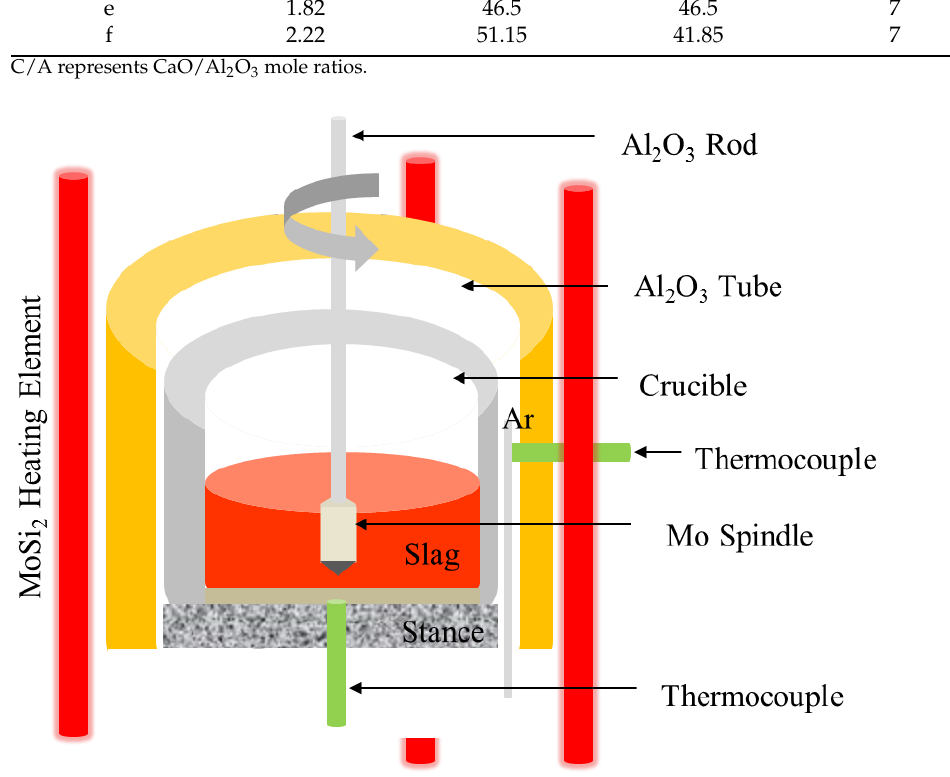
Figure 2. In the RDFs curve, the abscissa value corresponding to the first peak in the curve represents the average bond length of the particle pair. It can be seen from Figure 2a that the average bond length of Al-O, Ca-O, B-O, and O-O is 1.76, 2.33, 1.36, and 2.76 Å , re- spectively. L. Cormier et al. [23] proposed the Al-O and Ca-O bond length in calcium alu- minosilicate glasses is 1.76 and 2.35 Å by neutron diffraction. The B-O bond length in soda- boric oxide glass obtained by X-ray diffraction patterns is 1.37 Å [24]. The bond length values in this study are in good agreement with the experimental data, indicating that the MD simulations are reliable and accurate. Further analysis showed that the bond length of each particle pair in this study was not affected by the change in the CaO/Al 2 O 3 ratio and the addition of B 2 O 3 , as shown in Table 4. Table 4. Bond length of different particle pairs with different CaO/Al 2 O 3 mole ratio systems in this study. C/A